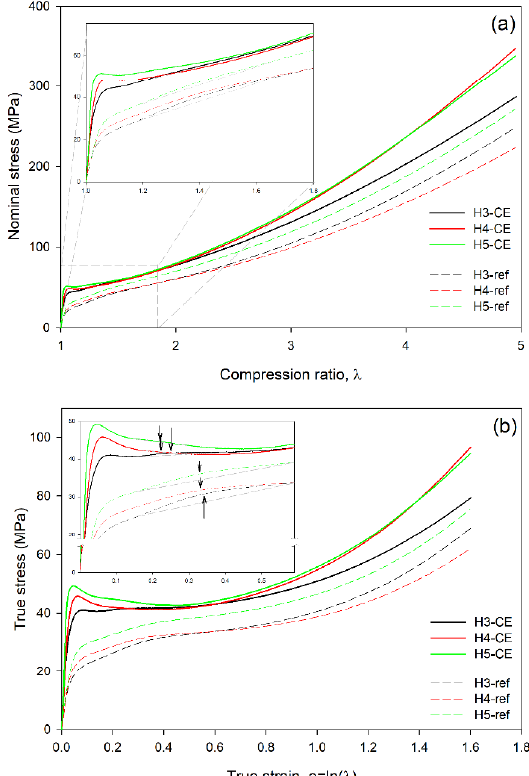
Figure 4. The experimentally determined dependencies of the nominal stress on the compression ratio ( a ) and the derived true stress-true strain curves ( b ). Equations (1) and (2) were used for calculations of true stress and true strain, respectively. Insets show enlarged initial part of the curves. Black arrows indicate the approximate location of the second yield.